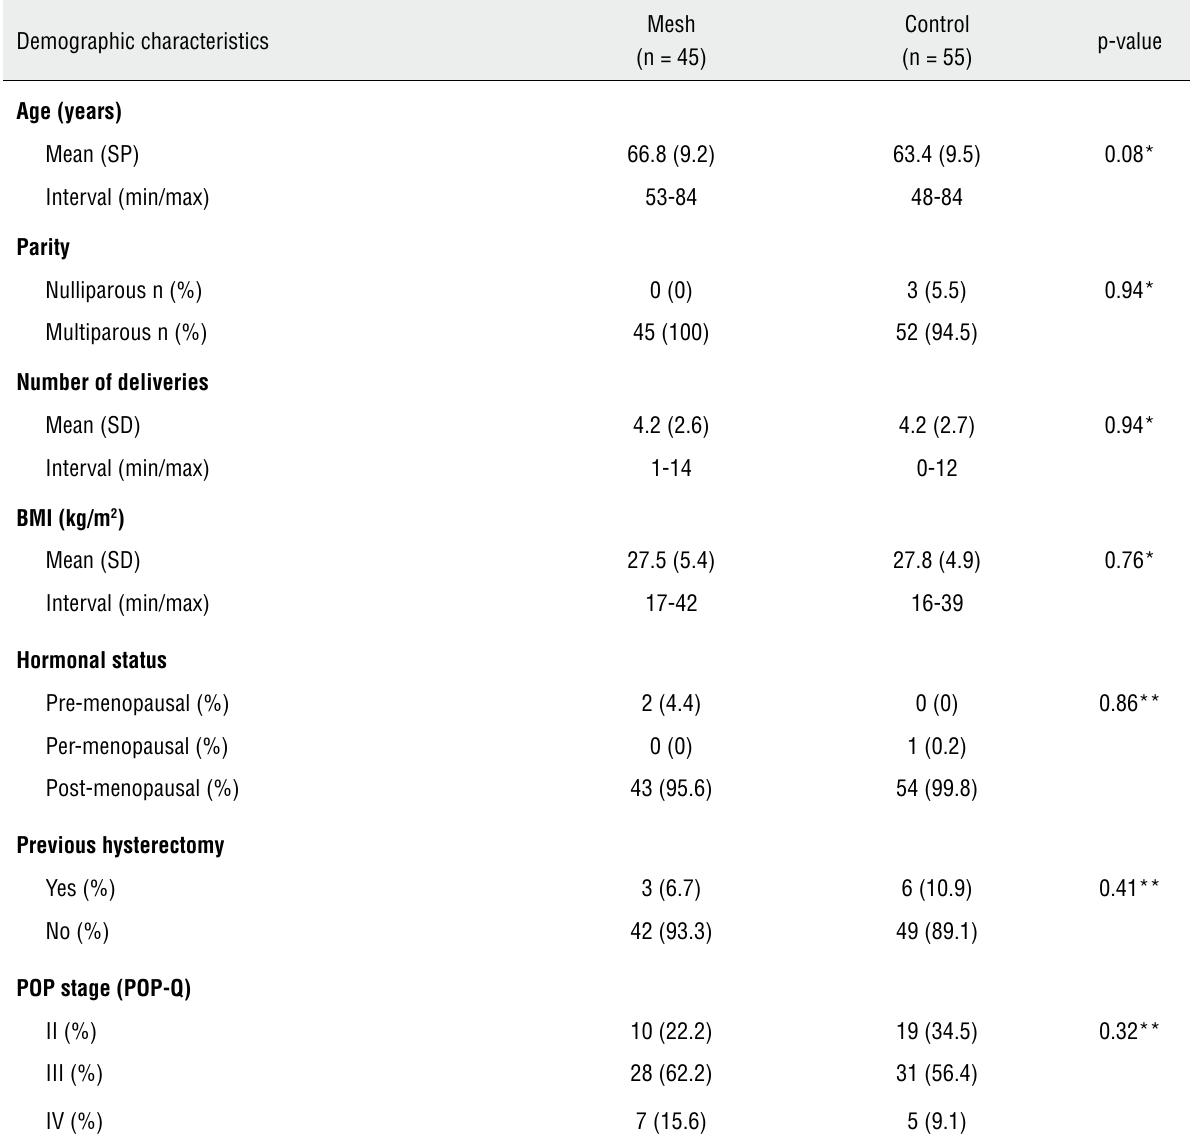
Table 1 - Demographic characteristics of the Mesh and Control groups during preoperatory period (n=100) Demographic characteristics